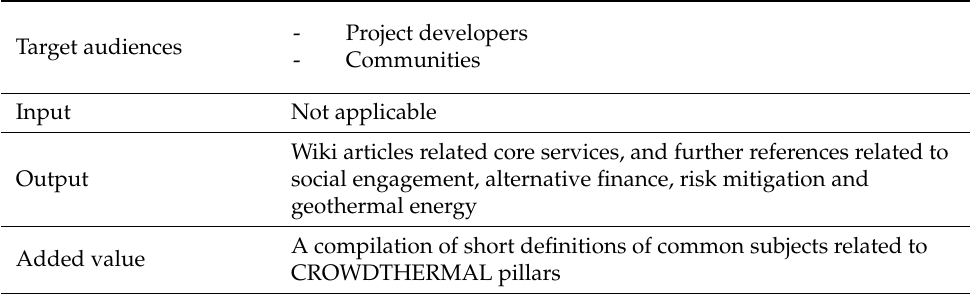
Figure 15. Wiki article about crowdfunding. Table 10. Self-learning catalogue.